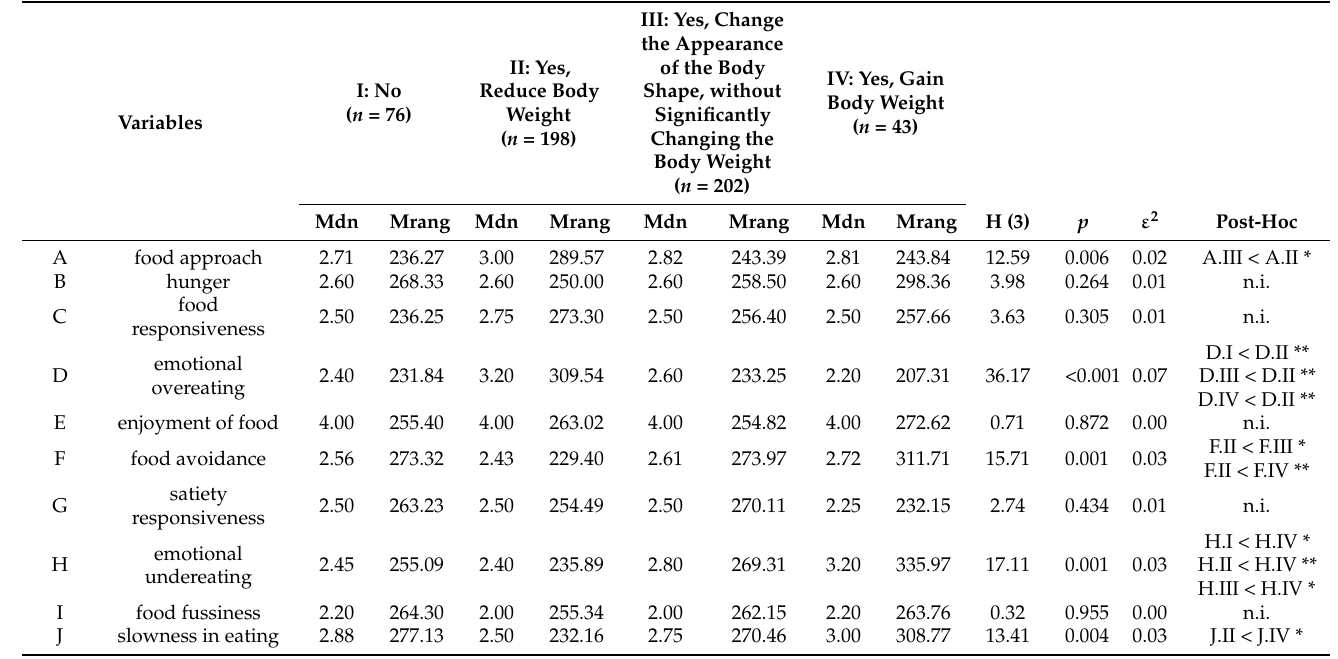
Table 12. Findings of intergroup comparison using Kruskal–Wallis H test along with post hoc tests on AEBQ-questionnaire dimensions and desire to change body image and/or